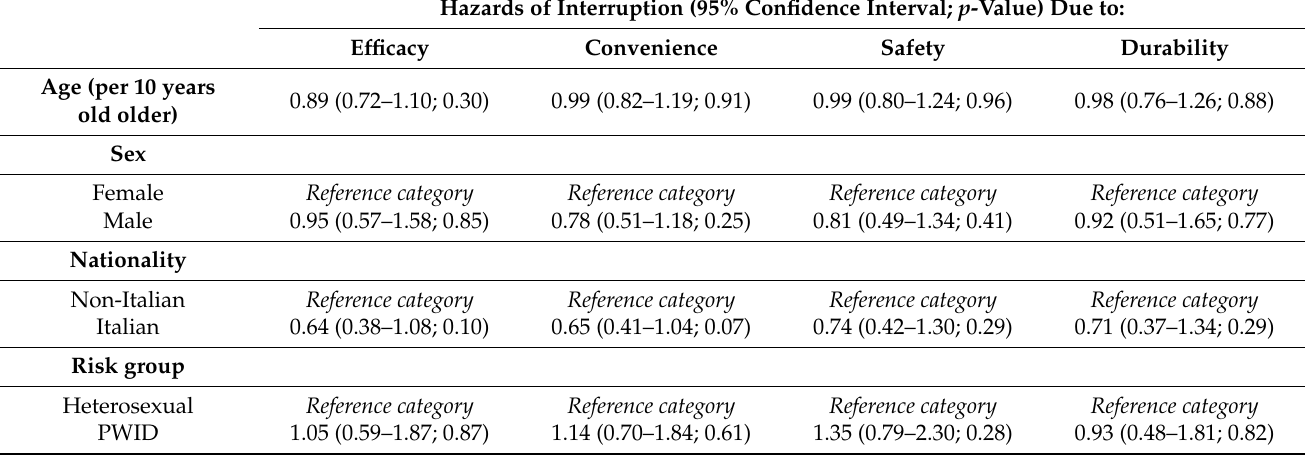
Figure 4. Kaplan–Meier survival curves show the time to a safety event of dolutegravir-based an- tiretroviral therapies among persons with HIV enrolled in the Italian MaSTER cohort. Plots are stratified by: ART backbone, FIB4 score, HIV RNA, previous ART, eGFR, CD4+ T-cell count. SAF, safety; ART, antiretroviral treatment; NRTI, nucleos(t)ide reverse transcriptase inhibitors; NNRTI, non-nucleos(t)ide reverse transcriptase inhibitors; INSTI, integrase strand inhibitors; PI, protease inhibitors; RPV, rilpivirine; TXF, tenofovir alafenamide or tenofovir disoproxil fumarate; XTC, emtric- itabine or lamivudine; 3TC, lamivudine; ABC, abacavir; DRV, darunavir; Boost, ritonavir-boosted regimens; OTH, other; eGFR, estimated Glomerular Filtration Rate. X -axis: time (days); Y -axis: survival rate (%). Table 2. Hazards of treatment interruption in relation to each of the outcome events (univariate analysis). Hazards of Interruption (95% Confidence Interval; p -Value) Due